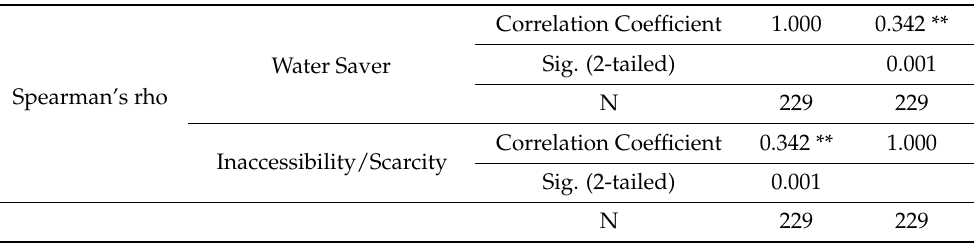
Table 5. Spearman’s rho correlations between water savers and water inaccessibility/scarcity. Correlation Coefficient 1.000 0.342 ** Sig. (2-tailed) 0.001 Water Saver Spearman’s rho N 229 229 Correlation Coefficient 0.342 ** 1.000 Inaccessibility/Scarcity Sig. (2-tailed) 0.001 N 229